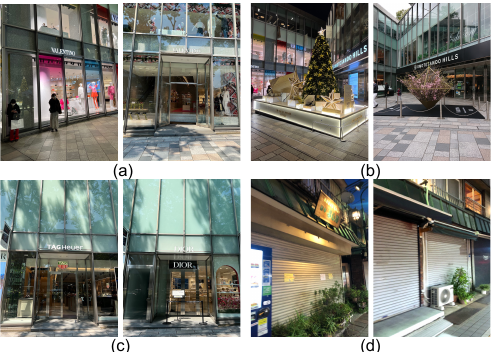
Figure 1. Examples of urban VPR challenges: ( a ) Appearance variance—daytime vs. illuminated; ( b ) Appearance variance—seasonal; ( c ) Perceptual aliasing—shops at the same building complex; ( d ) Perceptual aliasing—nearby closed shops with metal roll-down gates.